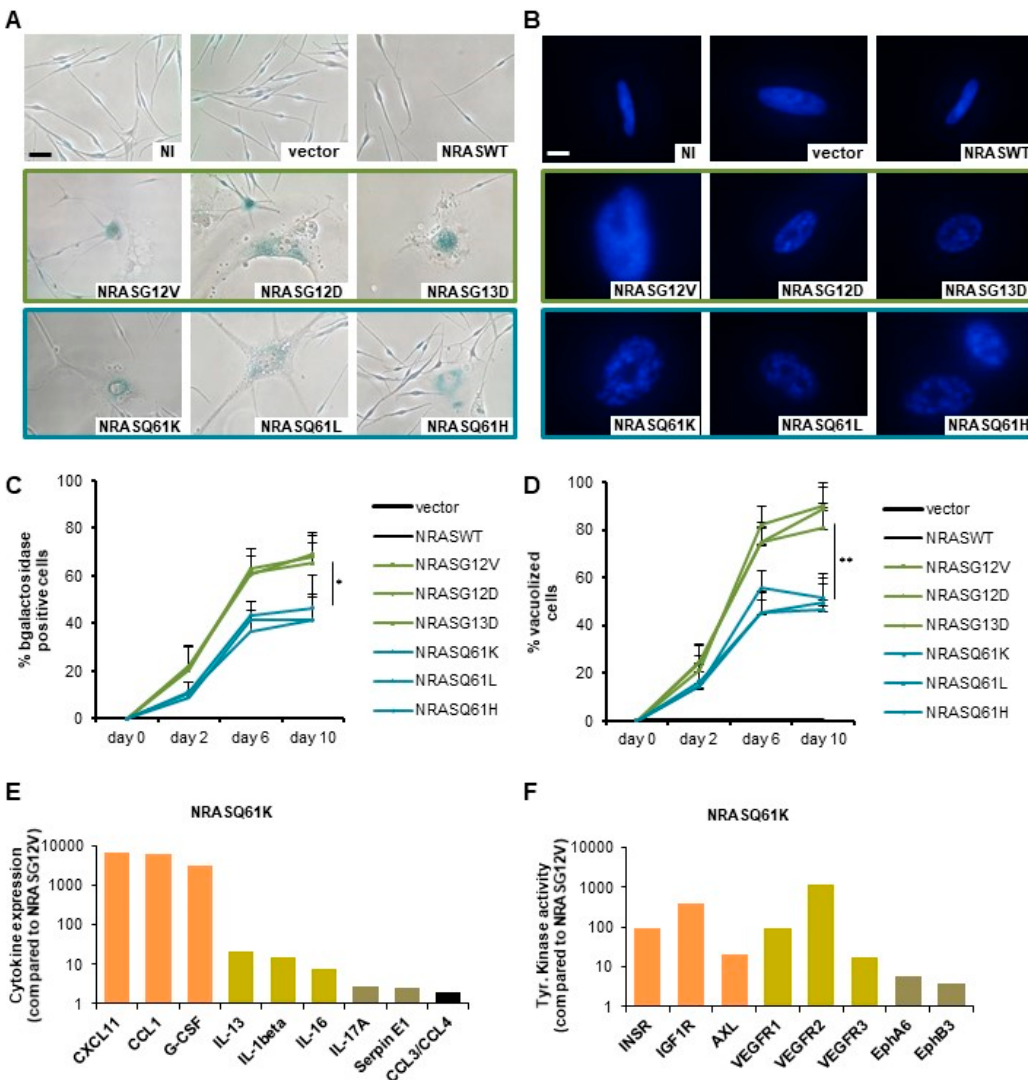
Figure 1. NRAS G12/13 mutants induce a stronger oncogene-induced senescence (OIS)-associated phenotype than NRAS Q61 mutants in normal human melanocytes (NHMs). ( A ) Normal human melanocytes (NHM) expressing indicated NRAS mutants were subjected to SA- β -Gal staining after 9 days. NI: non infected, vector: empty vector. Scale bar: 100 µm. ( B ) DAPI nuclear staining of NHM expressing indicated NRAS mutants shows an accumulation of OIS-associated heterochromatin foci (SAHF) with enlarged punctuated nuclei. Scale bar: 20 μ m. ( C ) Quantification of senescence-associated SA- β -Gal positive cells in percent. ( D ) Quantification of vacuolized cells in percent. ( E ) Protein expression of OIS-associated cytokines as a fold change to NRASG12V . ( F ) Tyrosine kinase activity as a fold change to NRASG12V . p values from three independent experiments by two-tailed, unpaired sample t test (* p < 0.05, ** p < 0.01, *** p < 0.005).